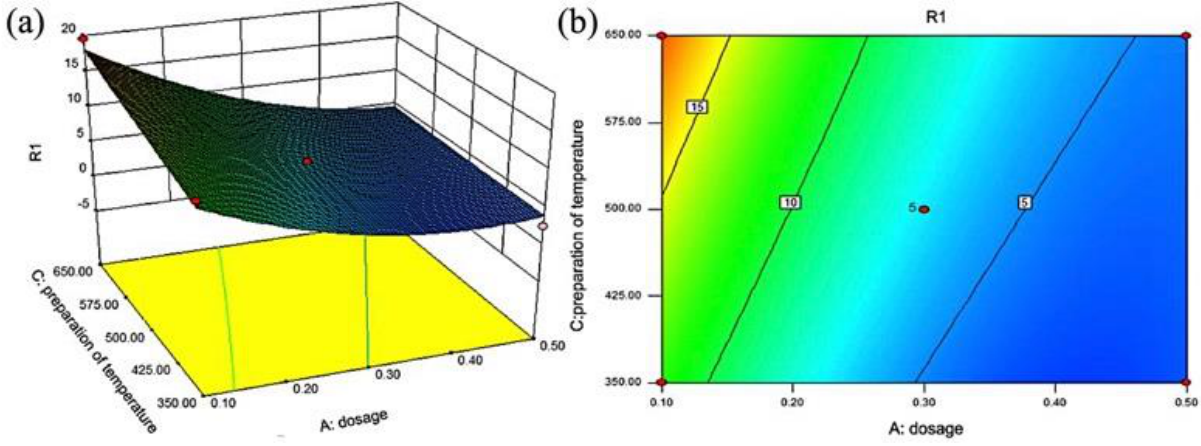
Figure 9. The ( a ) three-dimensional view and ( b ) top view for interaction between dosage D and preparation temperature T.